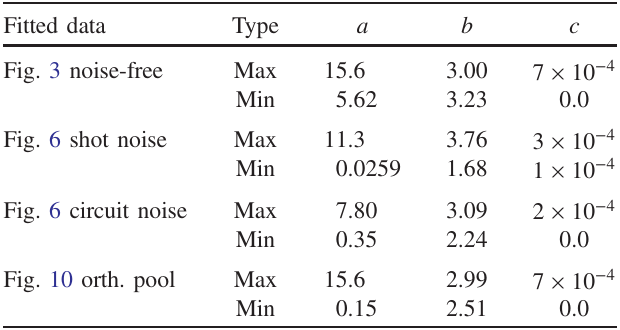
TABLE I. In our numerical simulations, we investigate the effect of increasing the number N of covariances. We fit a c function to the fidelity achieved by CoVaR of the form 1 − F ¼ a ð N = ν Þ − b þ c . Fits to the worst (Max) and best c (Min) of three runs of CoVaR are